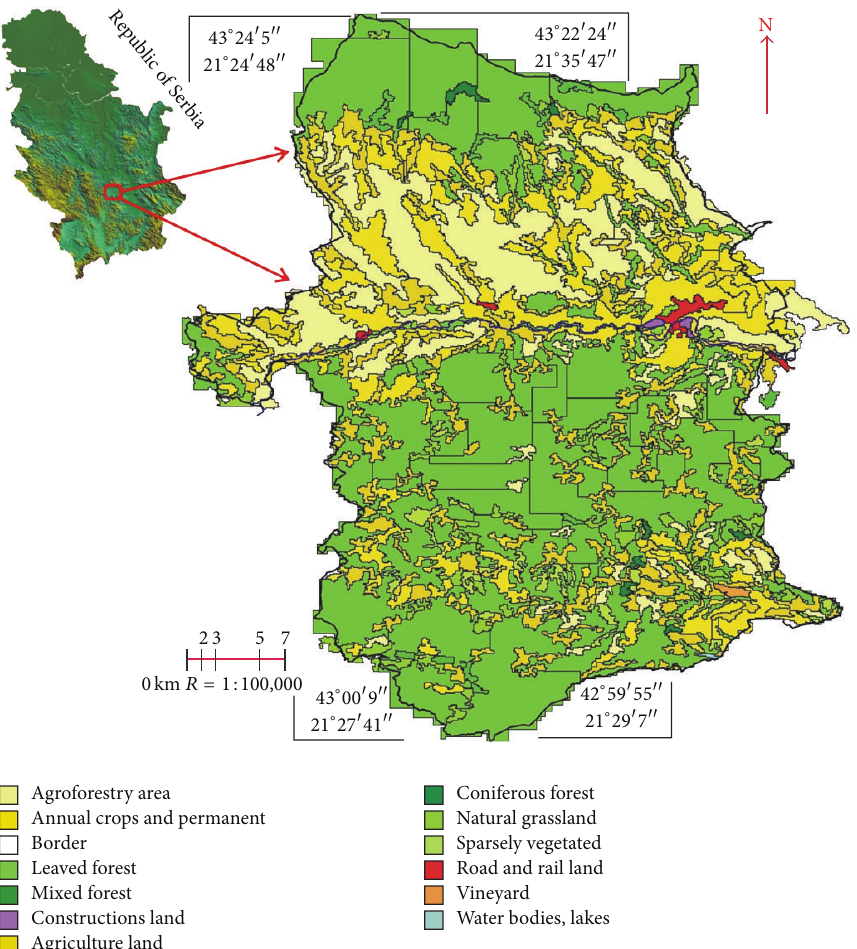
Figure 2: Digitized map of land cover on the territory of the Prokuplje Municipality in